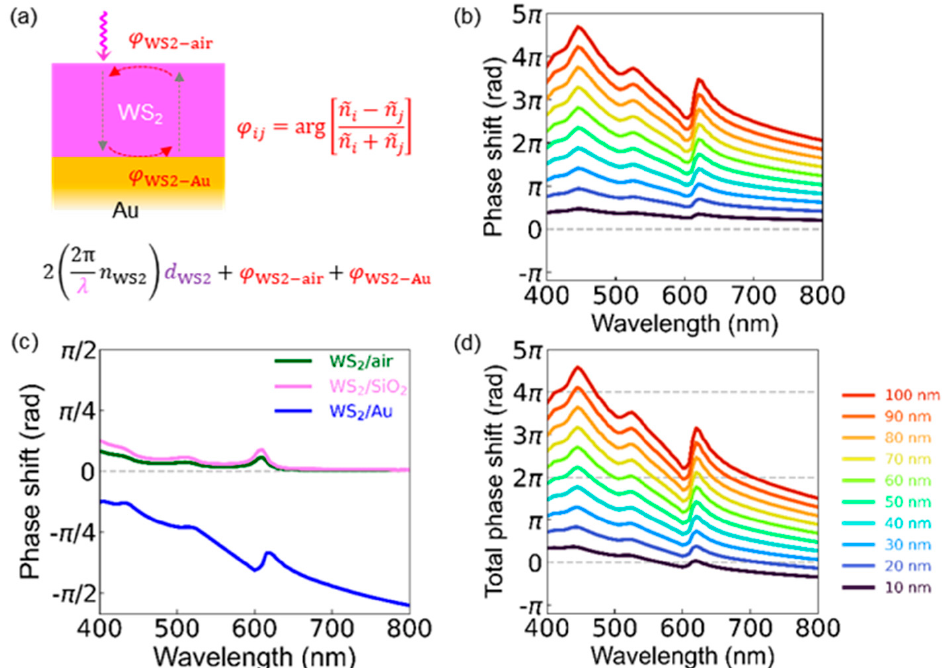
Figure 5. ( a ) Schematic diagram to illustrate the phase shift of light in WS 2 /Au (detailed explanations can be found in the text). ( b ) Calculated wavelength-dependent phase shift caused by round-trip propagration in WS 2 flakes with a d WS2 of 10~100 nm. ( c ) Complex Fresnel coefficient-related phase shifts of light reflected at the WS 2 /air, WS 2 /SiO 2 , and WS 2 /Au interfaces. ( d ) Total phase shifts of light for WS 2 /Au as a function of wavelength. The intersection points of the phase shift curves and dashed lines (0, 2 π , and 4 π ) indicate the wavelengths to form the resonant cavity modes in the WS 2 flakes.